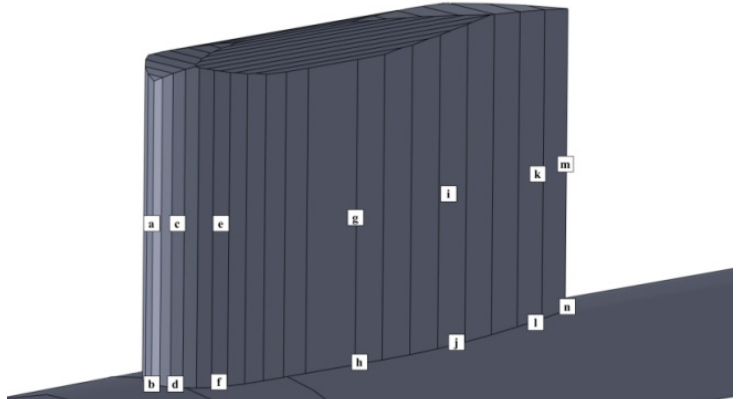
Figure 10. Locations of the field points. Points a, c, e, g, i, k, and m are located at the middle height of the sail hull. Points b, d, f, h, j, l, and n are located at the junction between the sail hull and the submarine body.